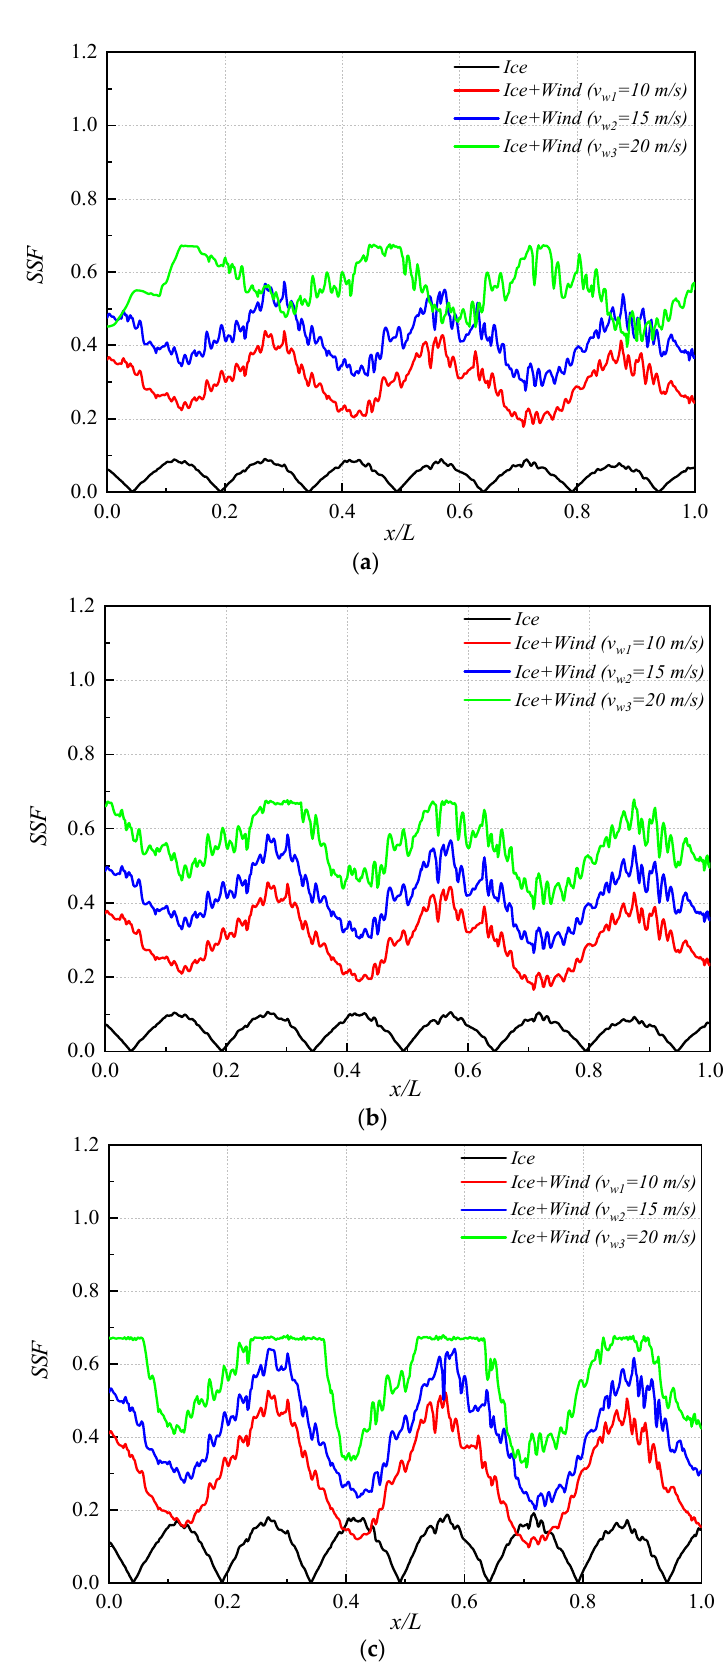
Figure 19. The SSF of the vehicle under combined ice and wind loads, ( a ) ice velocity v i = 0.2 m/s, ( b ) ice velocity v i = 0.6 m/s, ( c ) ice velocity v i = 1.0 m/s.